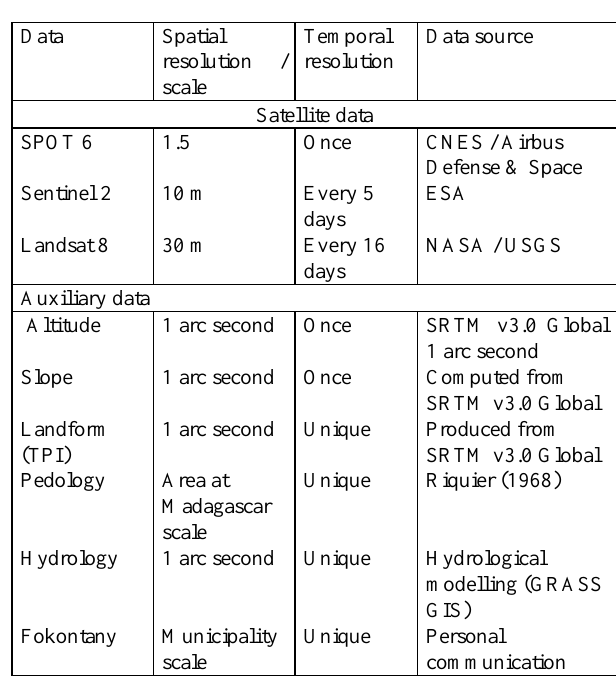
Table 1. Satellite and auxiliary data used in the